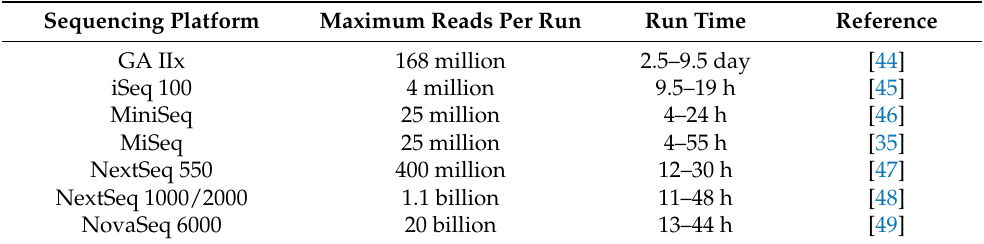
Table 1. Comparison of the maximum number of single reads per flow cell and run time of the Genome Analyzer IIx (GA IIx) and current Illumina sequencing platforms, according to the manufac- turer’s